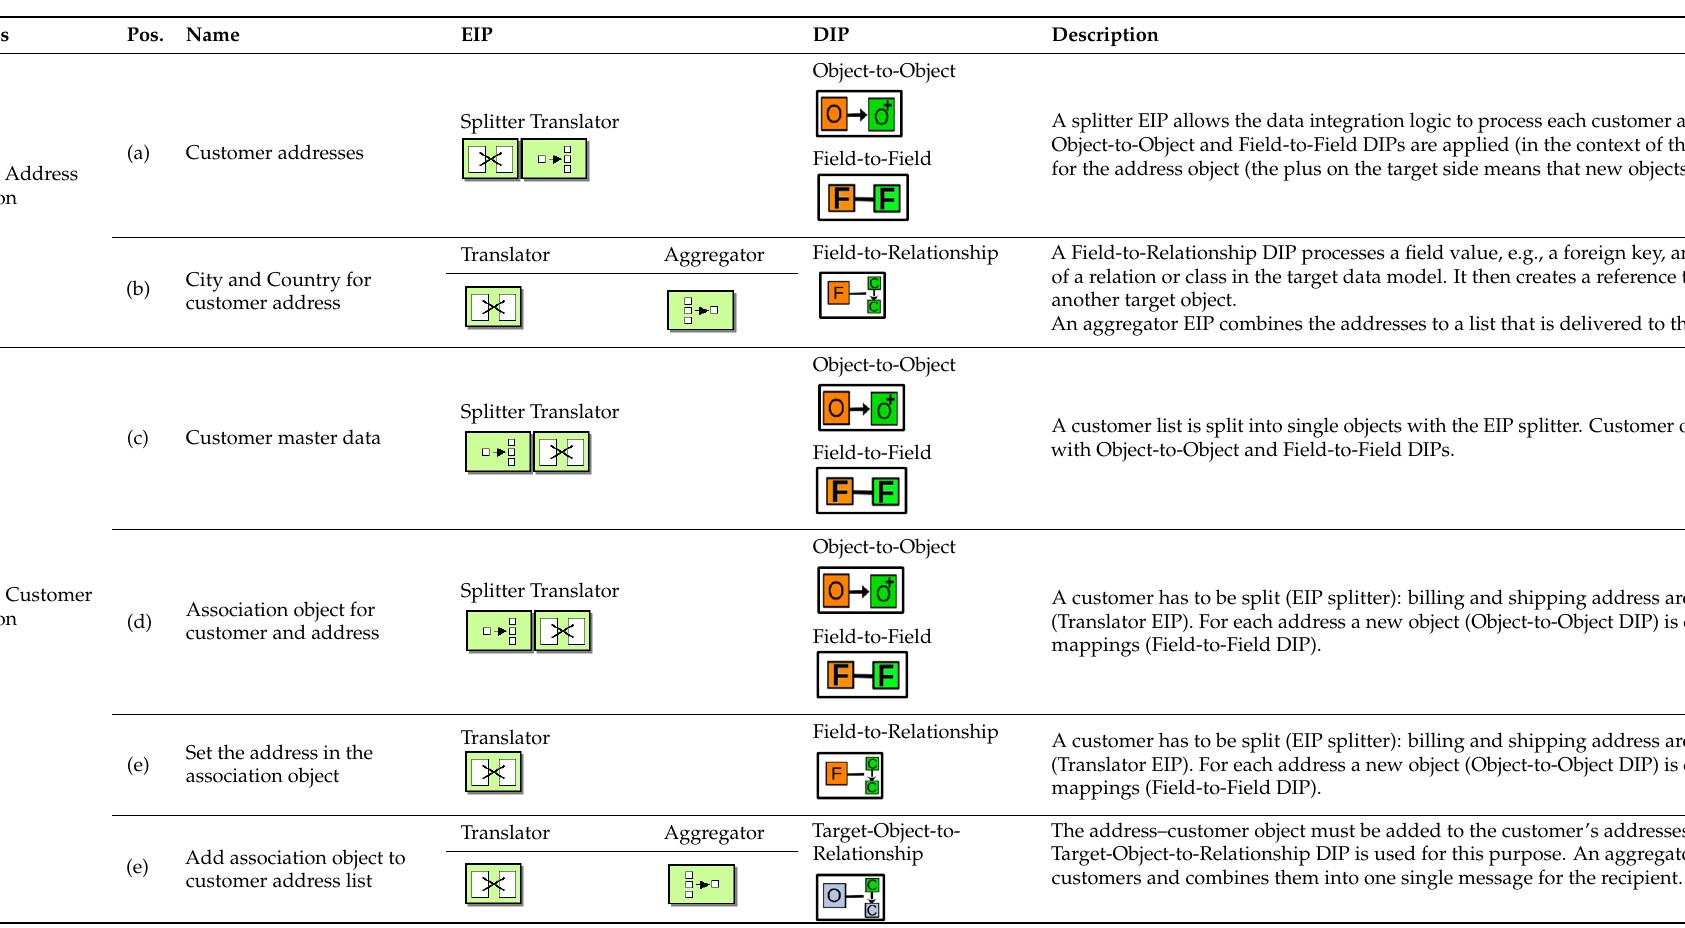
Table 5. Step 7: Application of EIPs and DIPs for the data integration tasks (Icons for EIPs taken from [42]).